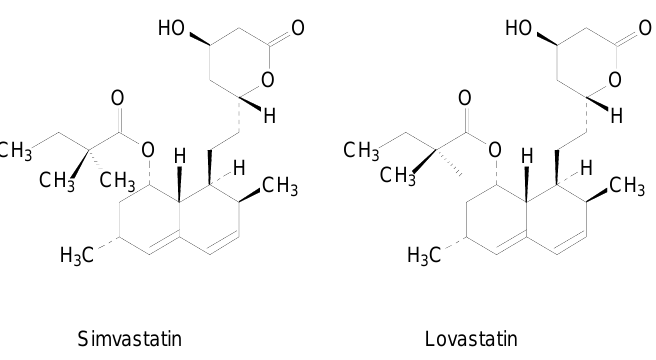
FIGURE 1 . Lovastatin: [1S-[1 α (R*),3 α ,7 β ,8 β (2S*,4S*)8 αβ ]]- 2 - methyl butanoic acid, mp 174.5 o C, [ α ] 25 D + 323 o C, C 24 H 36 O 5 , MW 404.55. Simvastatin: [1S-[1 α ,3 α ,7 β ,8 β (2S*,4S*),8 αβ ]]- 2,2 - dimethyl butanoic acid, mp 135–138 o C, C 25 H 38 O 5 , MW 418.57.